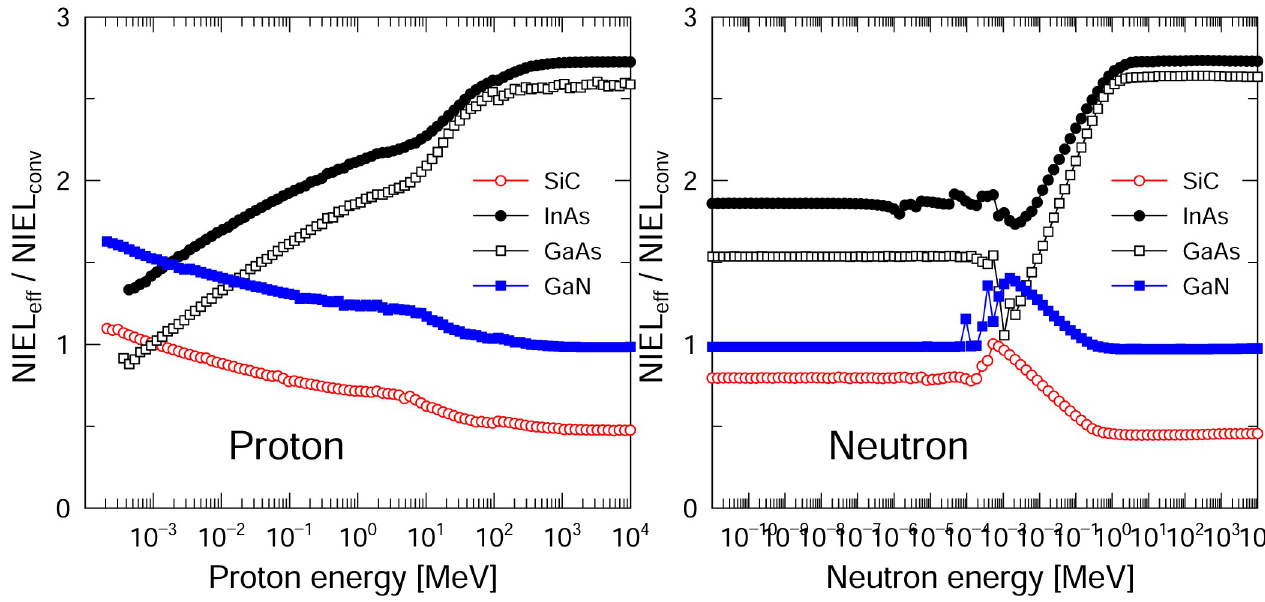
Fig 7. NIEL eff / NIEL conv ratios for semiconductors in response to proton and neutron irradiation.